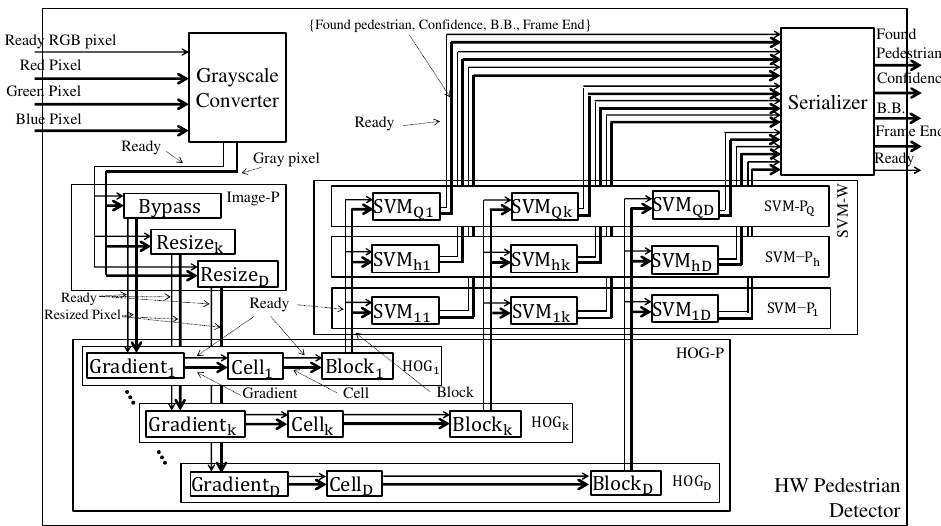
Figure 5. The general PD system hardware architecture. The terms Q and D is a simplification for the terms Q SVM-P and D pyr respectively. The term B.B. means bounding